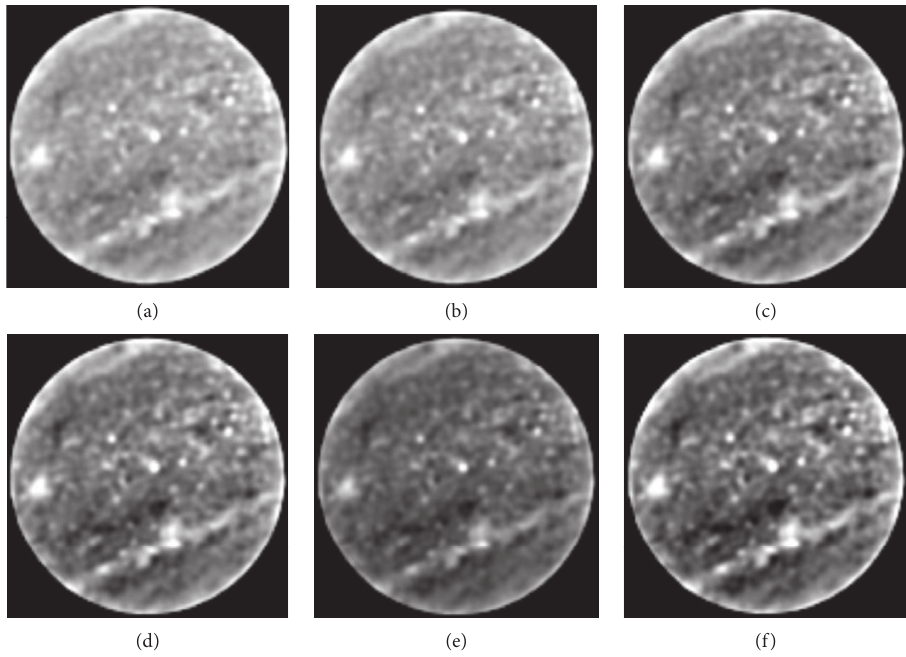
Figure 6: CTimages of the 10 th slice of coarse red sandstone A1 after freeze-thaw cycles. (a) 0 cycles. (b) 20 cycles. (c) 40 cycles. (d) 60 cycles. (e) 80 cycles. (f) 100 cycles.